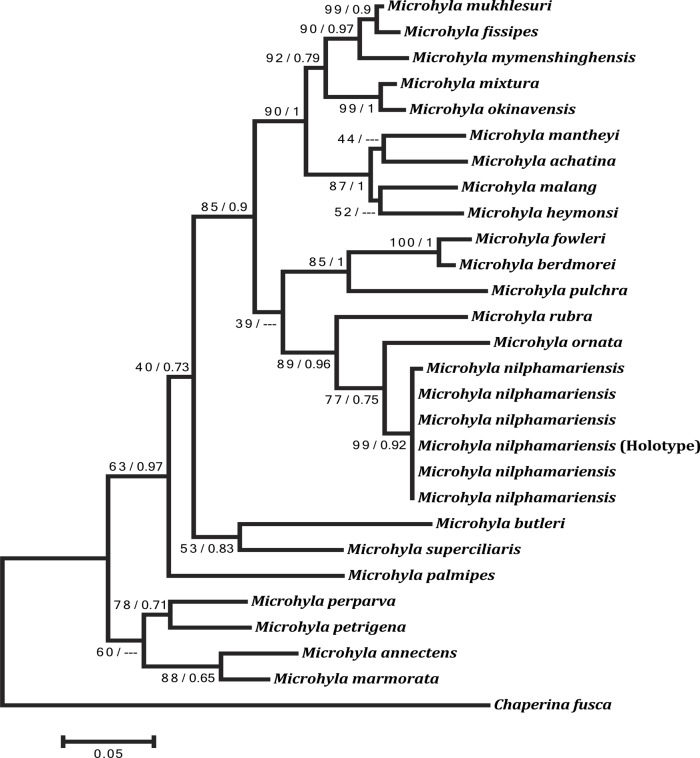
Phylogenetic relationships among all known species in the genus Microhyla.Analysis is based on 446 bp of mtDNA (16S gene) sequence, showing the position of Microhyla nilphamariensis sp. nov. Chaperina fusca was used as an outgroup. The Microyla ornata sequence is from Karnataka (Western Ghats, India). Numbers on branches represent bootstrap support values for Maximum-likelihood, and Bayesian posterior probabilities, respectively.